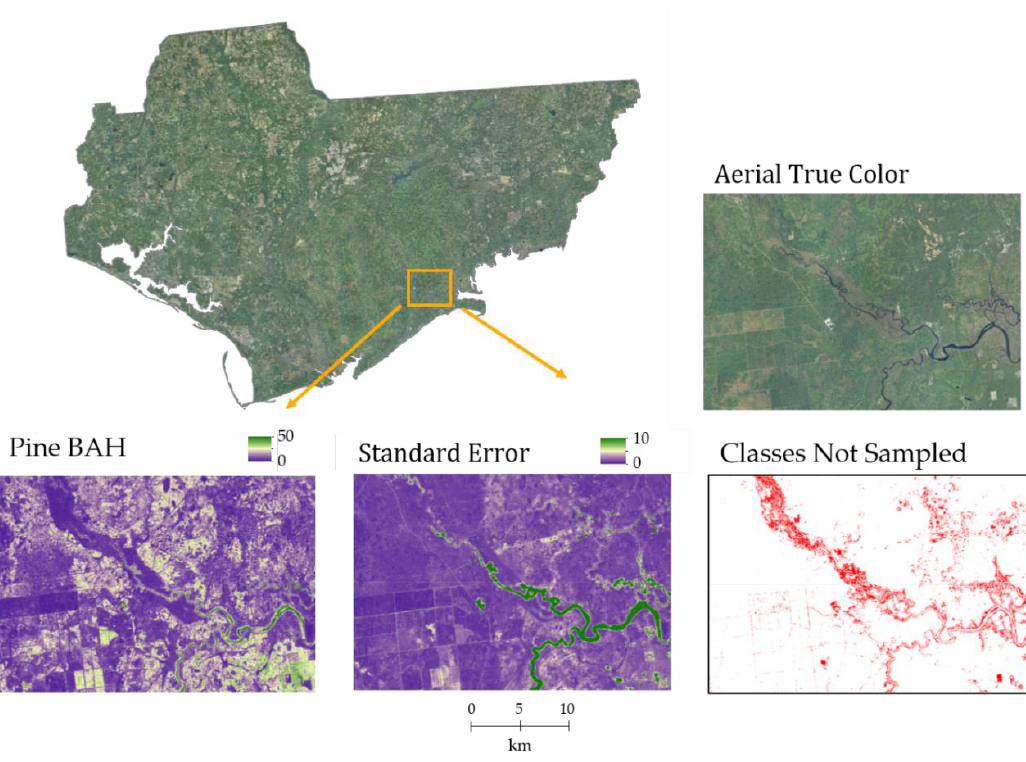
Figure 12. A close up example of locations with large standard errors in estimated Pine BAH owing to underrepresentation of feature space classes within the sample.